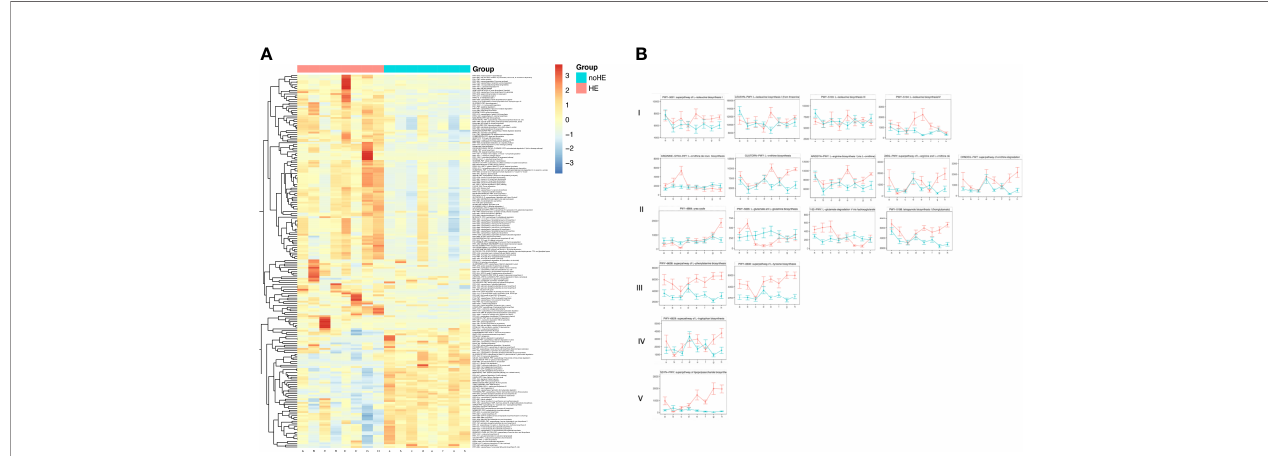
FIGURE 5 | Changes in metabolic pathways of the gut microbiome associated with HE. (A) Changes in metabolic pathways of gut microbiota in patients with and without HE. (B) Changes in HE-related metabolic pathways in the gut microbiota of patients with and without HE I – V occurred in fi ve main classes of pathway: increased synthesis of branched-chain amino acids (type I); pathways related to ammonia metabolism (type II); synthesis of aromatic amino acids (type III); synthesis of tryptophan (type IV); and synthesis of LPS (type V). Horizontal coordinates denote sampling times, with a – h corresponding to Day1, Week 1, Week 2, Week 4, Week 6, Week 8, Week 10, and Week 12 of the study, respectively. Vertical coordinates denote the abundance of pathways, expressed as RPK (number of reads per Kb base sequence). Red lines represent patients with HE and green lines represent